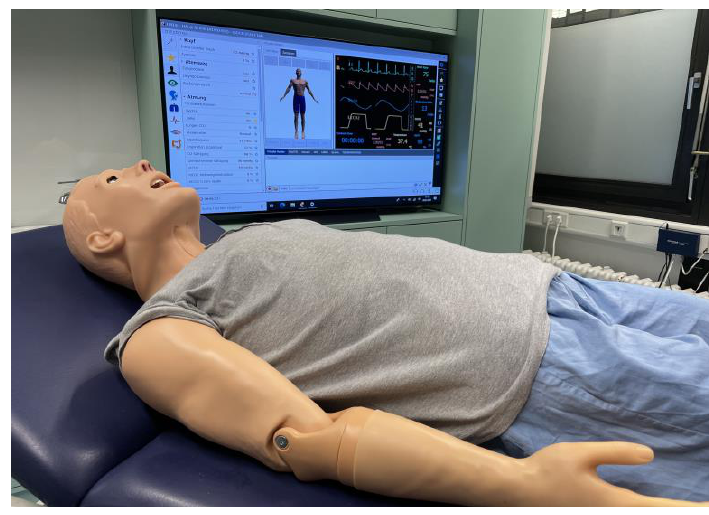
Figure 2. High-fidelity Simulator with Software showing vital functions.